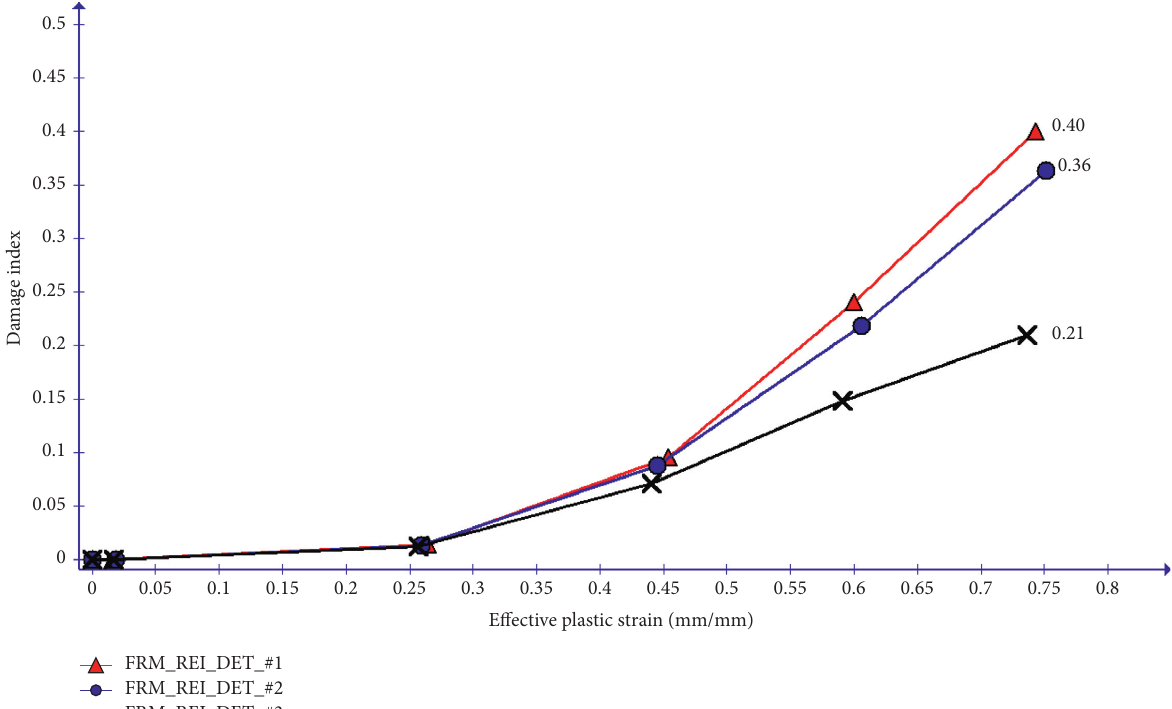
Figure 22: Column damage index vs. effective plastic strain plot 91kg TNT explosive located at the 2 nd story floor